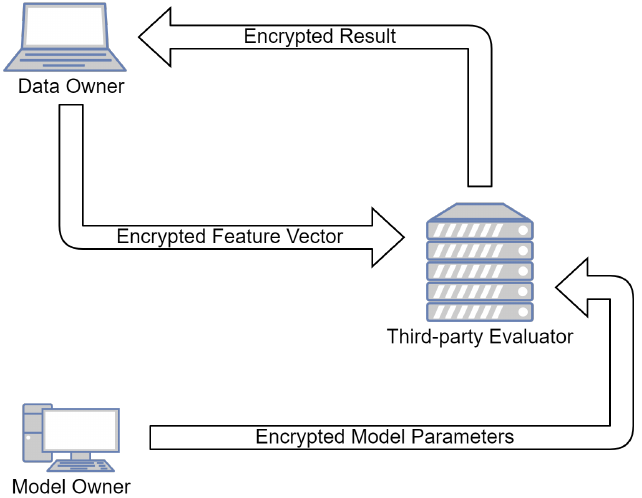
Figure 1. Private machine learning as a